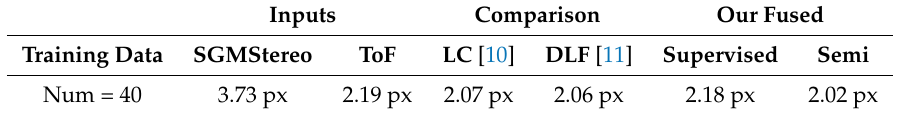
Table 7. Mean absolute disparity error of ToF-stereo fusion on SYNTH3 (15 test samples). Inputs Comparison Our Fused